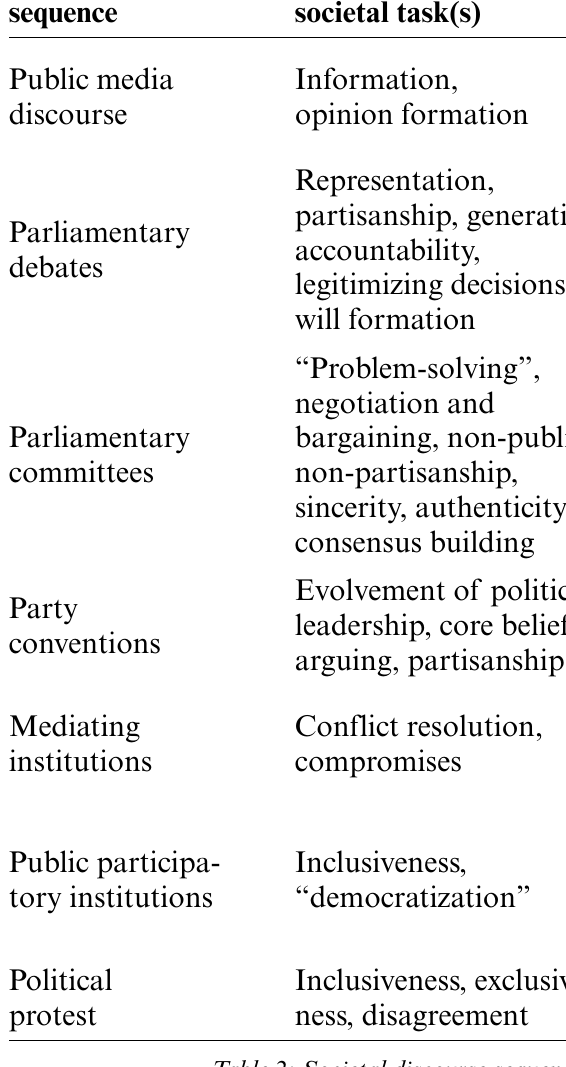
Table 2: Societal discourse sequences, functions and deliberative